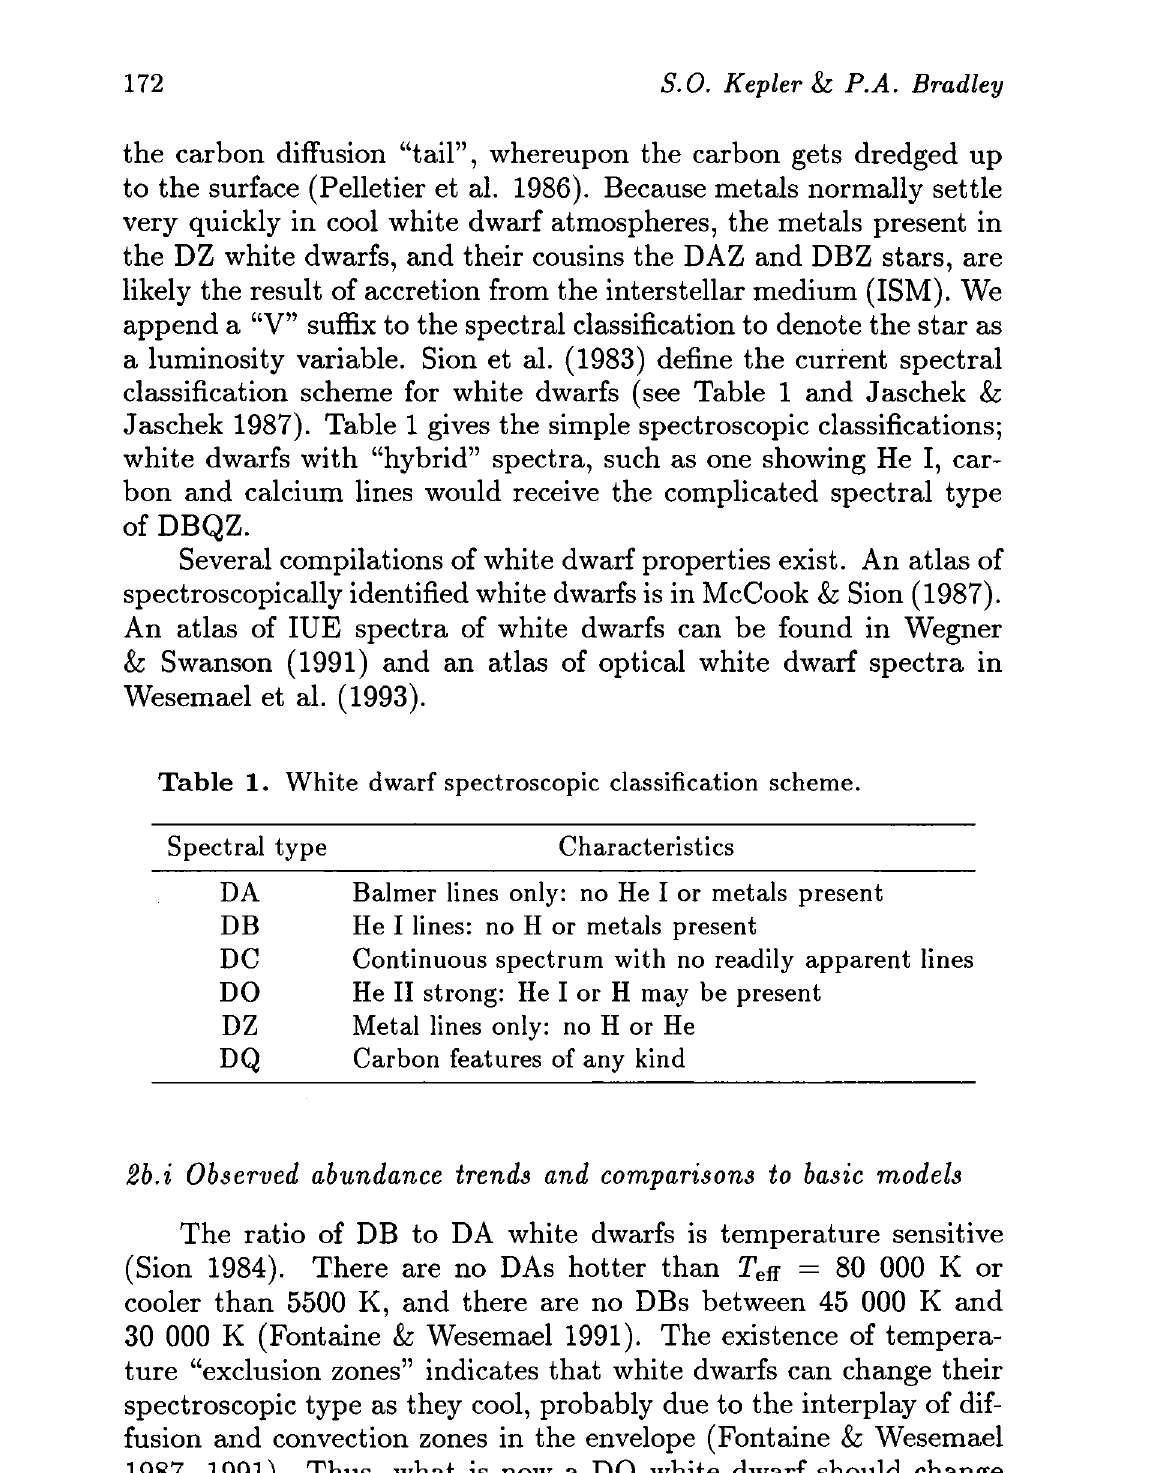
Table 1. White dwarf spectroscopic classification scheme. Spectral